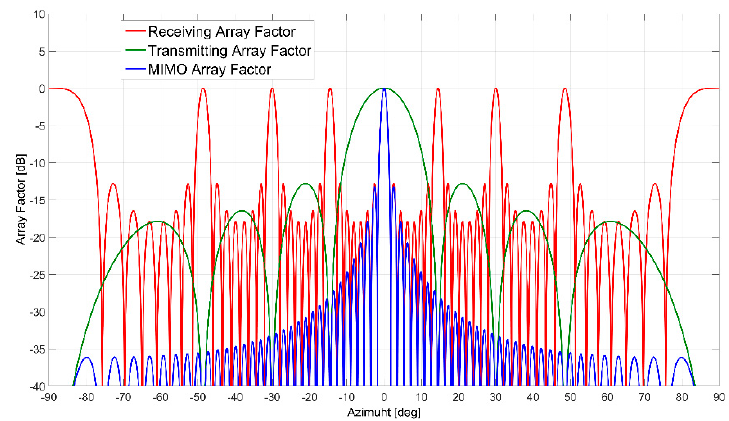
Figure 1. MIMO array factor (in blue), obtained from the product of a transmitting array factor (in green) and a receiving array factor (in red).